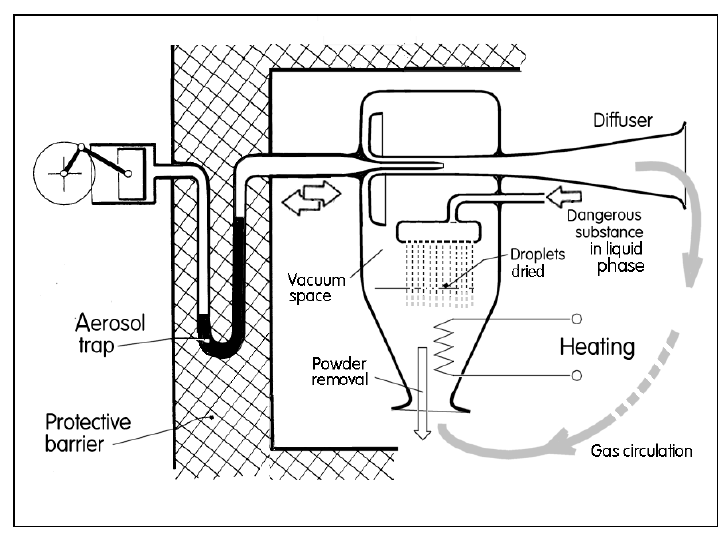
Figure 16. Drying in vacuum generated in the rectifier and its diffuser-shaped mixing tube. Energies 2019 , 12 , x FOR PEER REVIEW 16 of 20